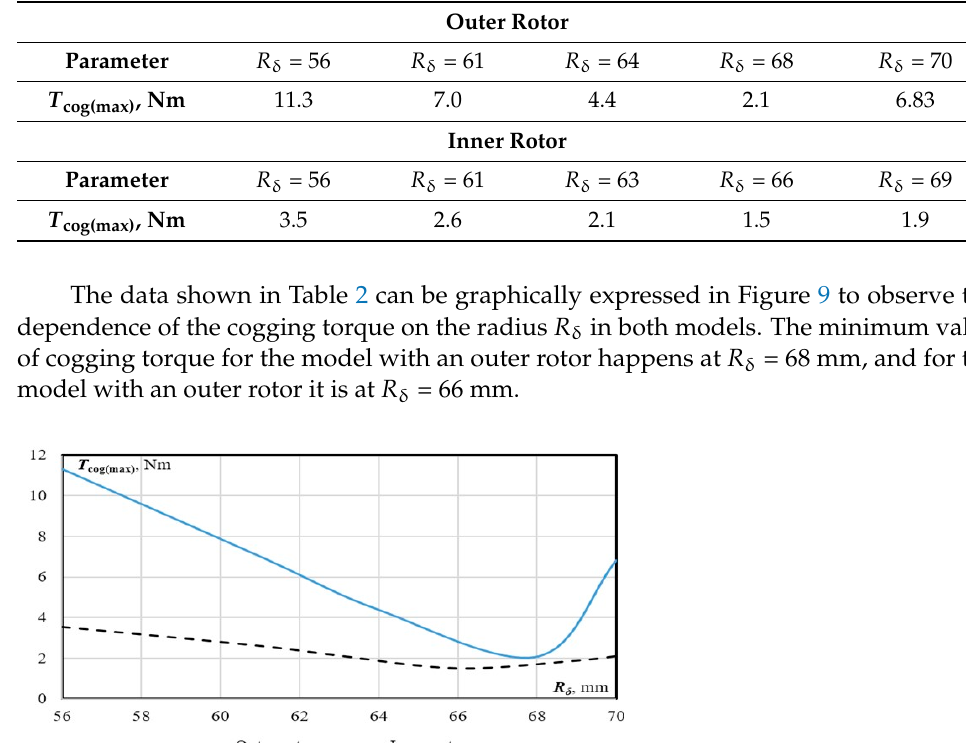
Figure 8. The torque characteristics of the single-phase TFMs with outer and inner rotors at various air-gap radius 𝑅 δ : ( a ) cogging torque TFM with an outer rotor; ( b ) cogging torque TFM with an inner rotor; ( c ) electromagnetic torque with an outer rotor vs. rotor mechanical angle J = 5 A/mm 2 ; and ( d ) electromagnetic torque with an inner rotor vs. rotor mechanical angle. Table 2. Cogging torque values of the TFM with an outer and inner rotor at various air-gap radii.